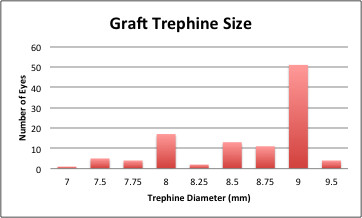
Distribution of Graft Trephine size.